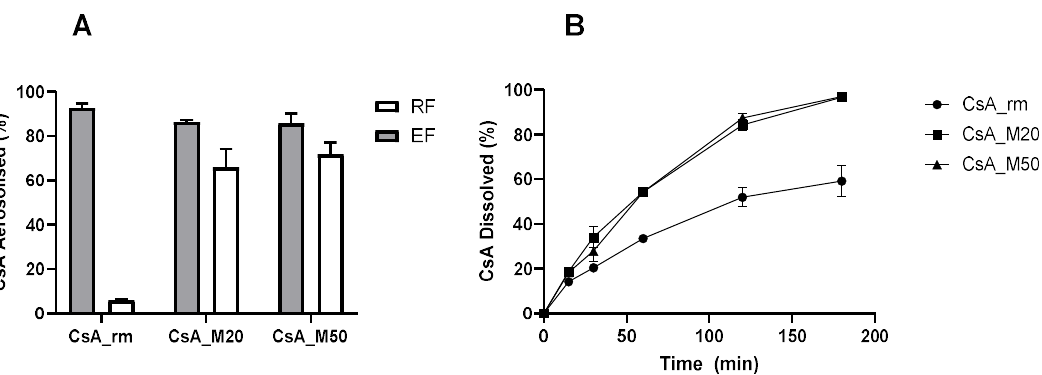
Figure 1. Aerosolisation performance (RF = respirable fraction, EF = emitted fraction) ( A ) and dissolution profiles ( B ) of CsA raw material (CsA_rm), CsA_M20, and CsA_M50. Data presented as n = 3, mean value ± SD.